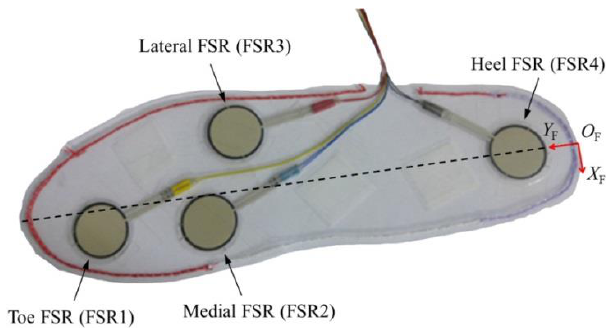
Figure 7. Insole sensor for measuring plantar pressure distribution.